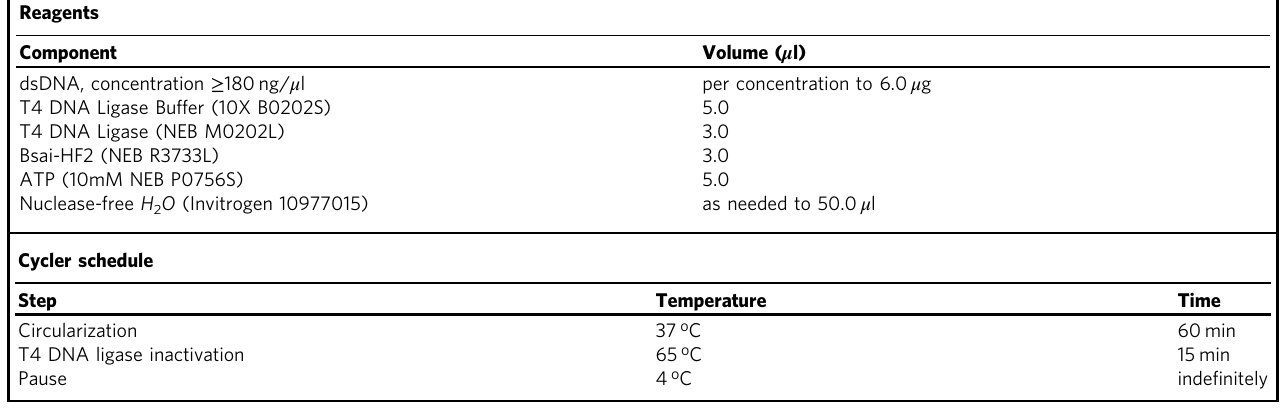
Table 2 Circularization reaction ingredients for 6.0 μ g of input dsDNA in 50 μ l and cycler